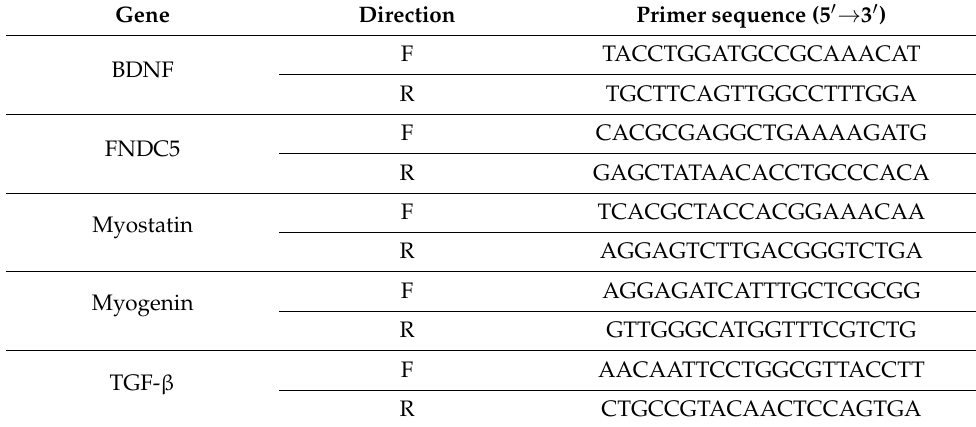
Table 1. Primer sequences for mouse